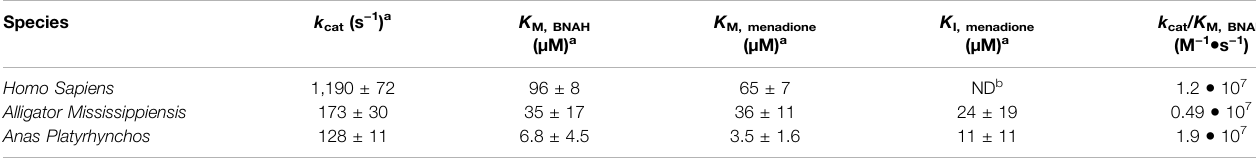
a Indicated errors are the approximate 95% con fi dence limits. b There was no observed substrate inhibition at the concentrations of menadione used.